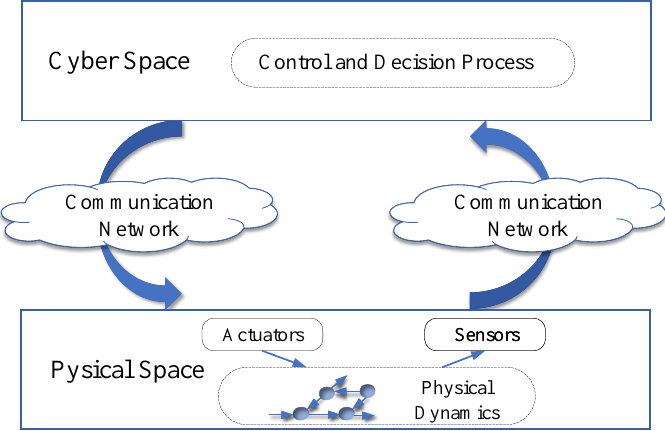
Figure 1. General framework of complex cyber–physical